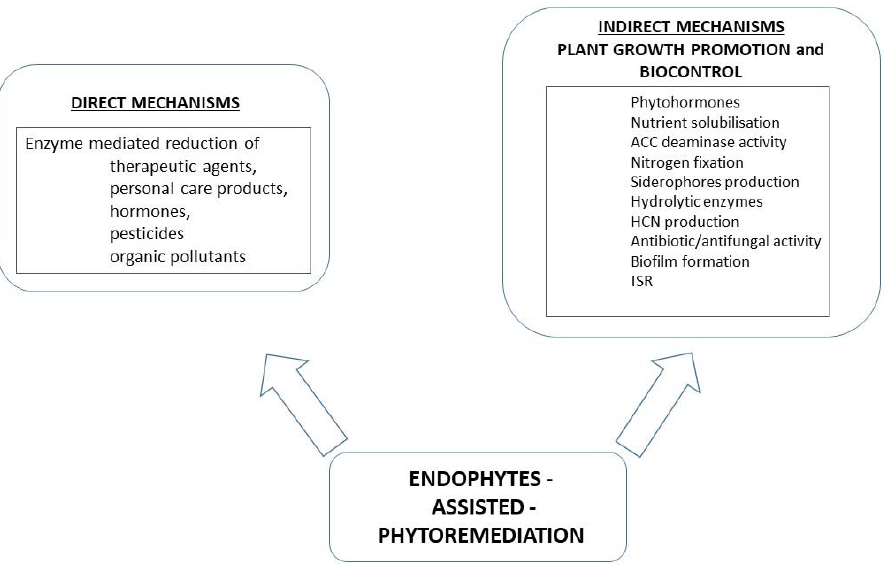
Figure 1. Possible mechanisms of boosting phytoremediation with participation of bacterial endophytes.